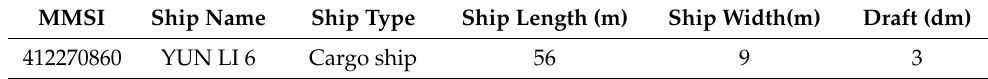
Table 2. Cargo ship static information table.